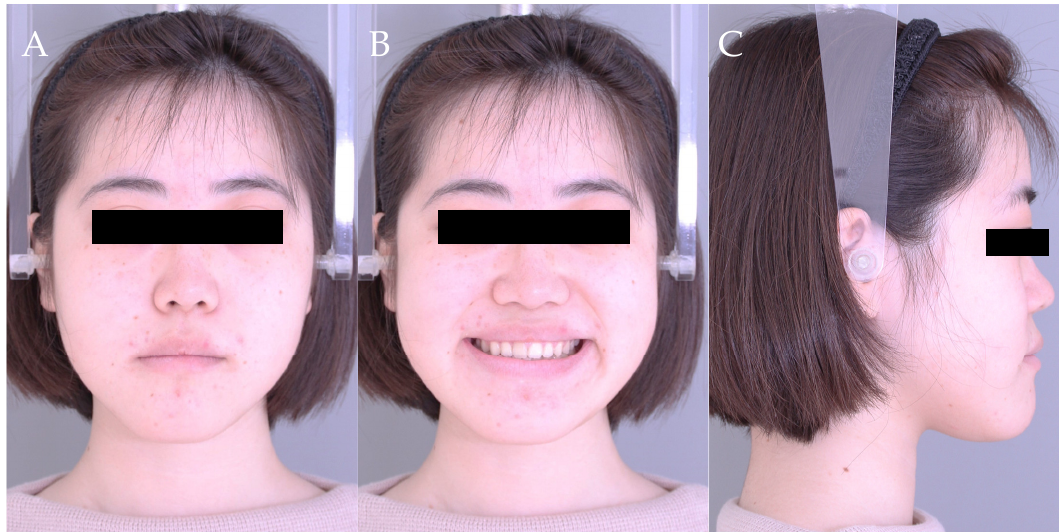
Figure 8. Post-treatment facial photographs. ( A ) Front view; ( B ) smile view; ( C ) lateral view.